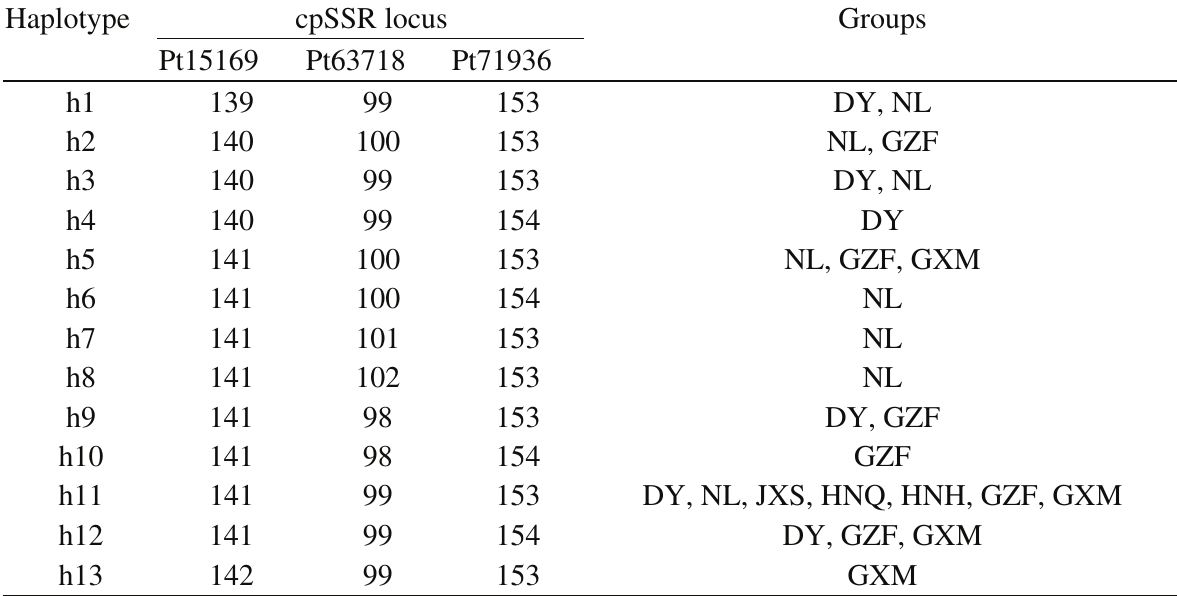
Table S2 Haplotypes and their distribution in populations of